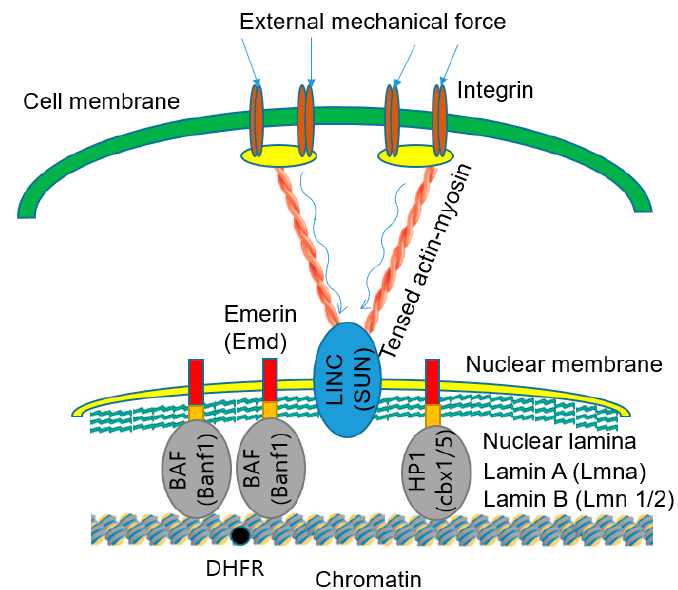
Figure 5. Propagation of external mechanical force from integrins to chromatin [124]. External mechanical forces applied to the cell surface are propagated via integrins and tensed actin-myosin cytoskeleton to LINC complexes and nuclear lamins in the nuclear lamina. The forces are then transferred to the chromatin through heterochromatin protein (HP1), Barrier-to-autointegration factor (BAF) proteins, and other molecules. The forces transferred to the chromatin stretch deform the chromatin segment that contains the DHFR gene. The deformation and stretching of chromatin facilitate binding of transcription factors to the DHFR gene for the upregulation of the DHFR gene transcription. The external mechanical force was provided by ferromagnetic beads attached to integrins in a magnetic field. The magnetic stress was 17.5 Pa.